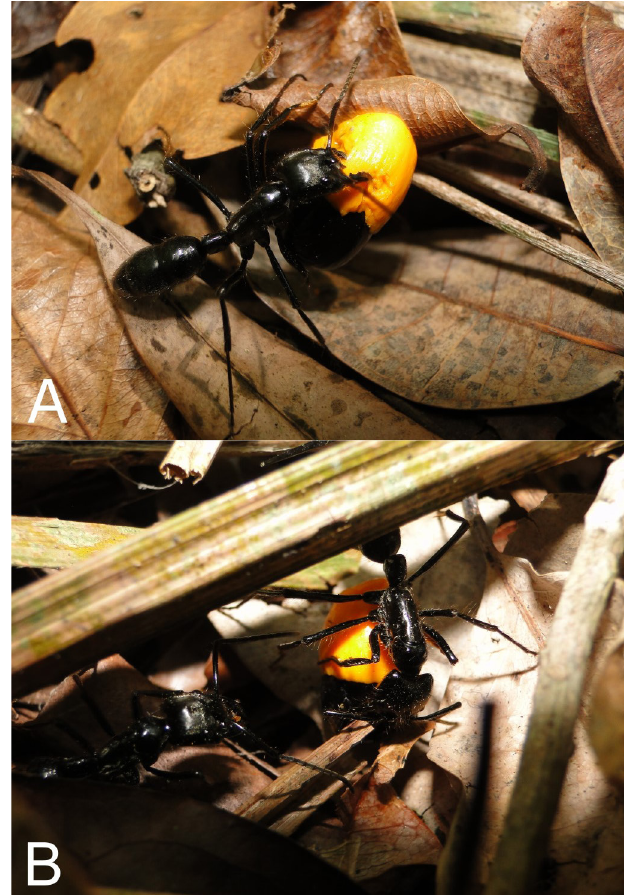
Fig 2 . Dinoponera lucida workers at the Reserva Natural Vale, state of Espírito Santo, Brazil. (A) Seed of Swartzia myrtifolia var elegans transported by a worker, (B) foraging workers from the same nest in cooperative interaction to transport the seed.